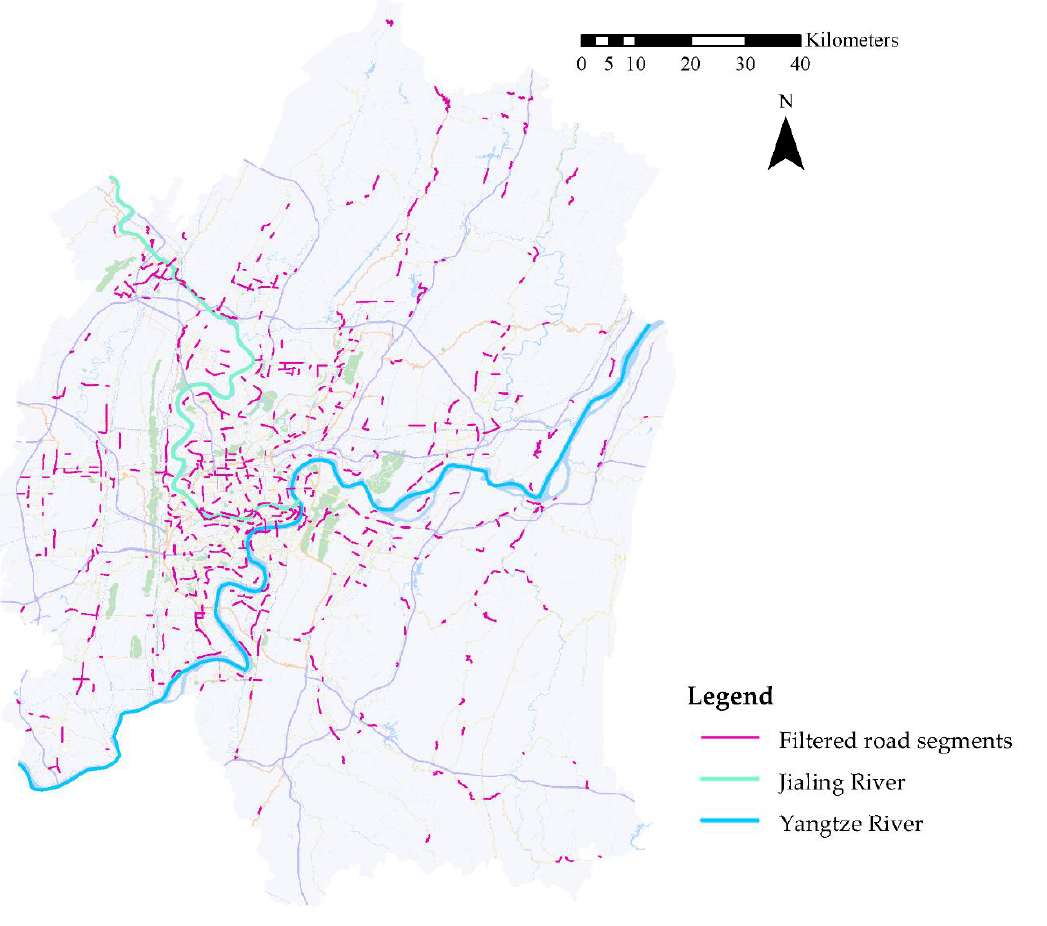
Figure 1. Spatial distribution of filtered road segments.